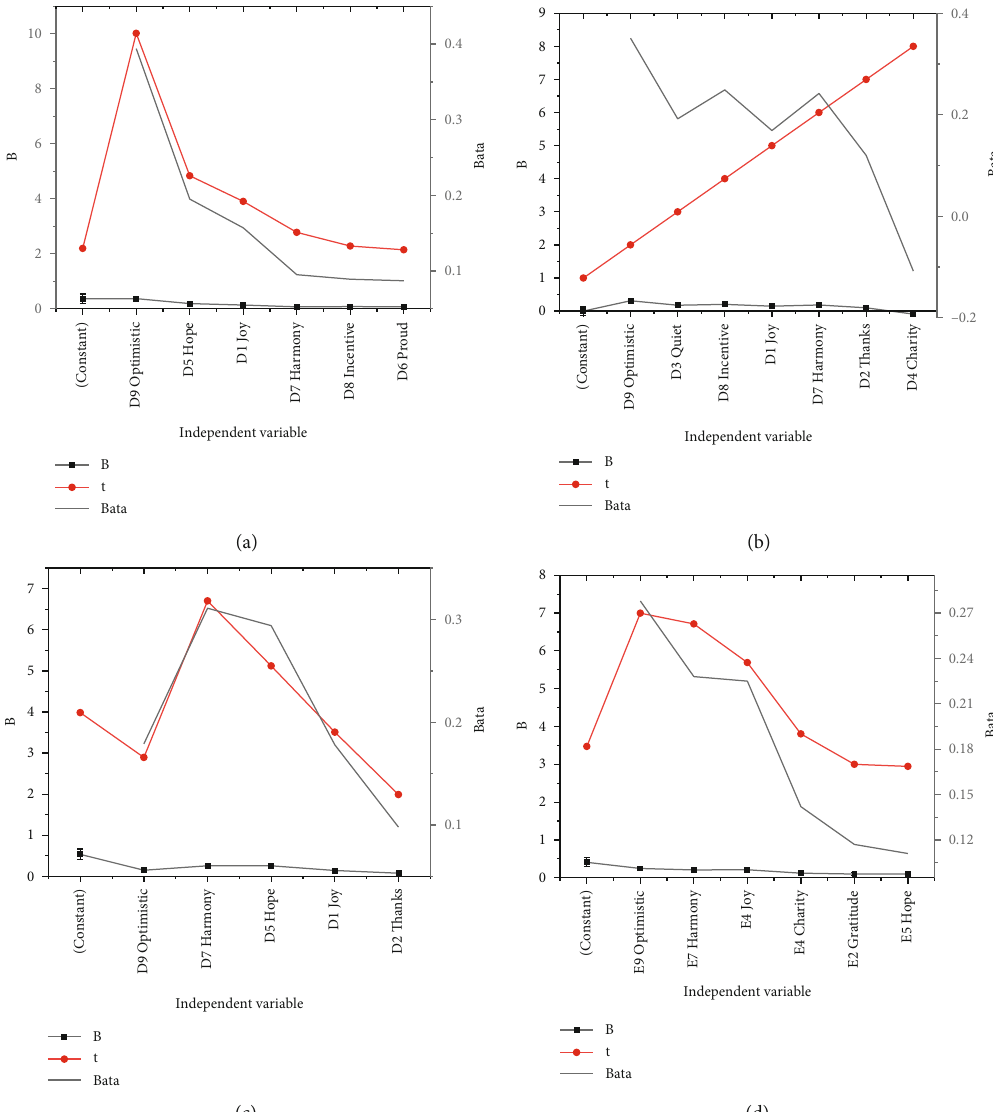
Figure 13: QS results of enhancement e ff ects of di ff erent music styles on positive emotions around the world ((a) “ Waltz of the Danube ” ; (b) “ Deep Breathing Freely ” ; (c) “ Harry Potter and Chamber of Secrets ” ; (d) “ Blue Love ” ; B is the nonstandardized coe ffi cient; t denotes emotional